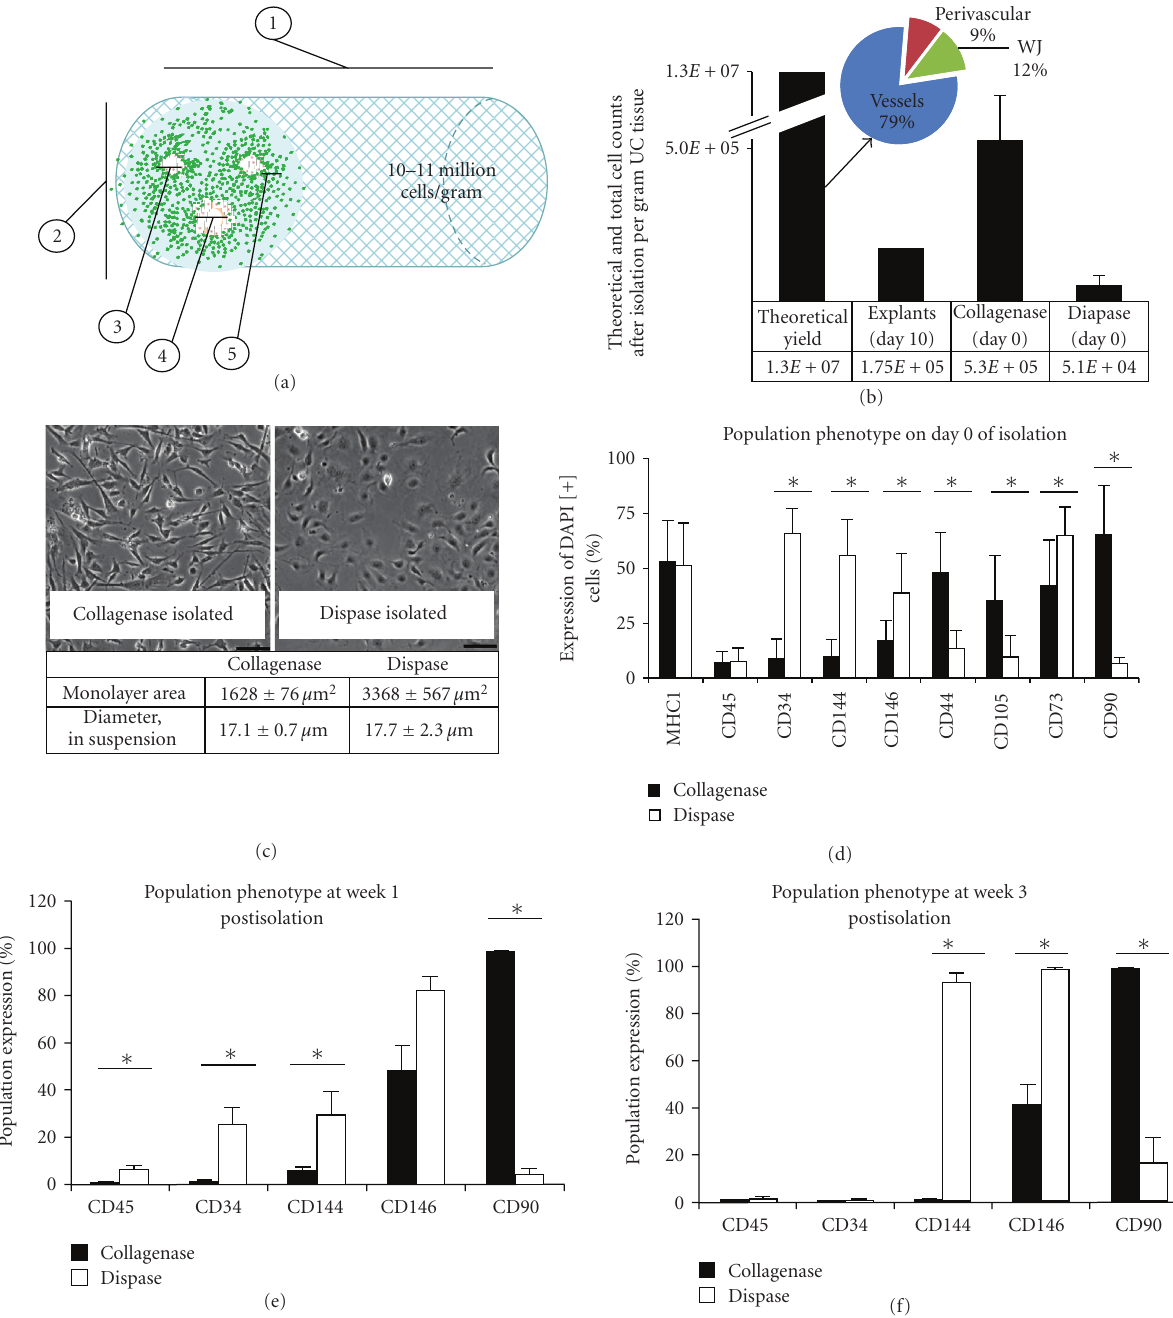
Figure 2: Tissue processing and method of isolation a ff ect total cell yield and population phenotype. (a) Physical properties of the UC tissue provide an estimate that 10-11 million cells per gram can be isolated from the tissue (also see Table 1 and Table 1 in Supplementary Material available online at doi:10.1155/2009/789526). (b) The theoretical yield of 10-11 million cells/UC gram includes 79% vascular cells, 9% perivascular cells, and 12% WJ cells. Distinct phenotypes based on enzymatic method are evident by both morphology (c) and molecular phenotype (d)–(f). (c) Cell area or spreading in 2D monolayer is significantly larger for dispase-isolated cells versus collagenase-isolated cells (mean ± s.e.m., P < . 001), although the cells have similar diameter or size when measured prior to surface adhesion. (d) Mean surface marker expression on day 0 of isolation. Collagenase-isolated cell populations have a significantly higher level of expression of CD44 ( P = .005), CD105 ( P = .014), and CD90 ( P < .001), as compared to dispase-isolated cells that exhibit a significantly higher level of endothelial marker expression, CD34 ( P < .001), CD144 ( P < .001), and CD146 ( P = .049), and CD73 ( P < .001) which was also detected in the endothelium. (e) Marker expression at week 1 postisolation. Significant di ff erences were detected for expression of CD45 ( P = .01), CD34 ( P < .001), CD144 ( P = .006), and CD90 ( P = .003). (f) Marker expression at week 3 postisolation. Significant di ff erences were detected for expression of CD144 ( P = .017), CD146 ( P = .008), and CD90 ( P = .001). The use of collagenase enzyme yields a cell population with significantly higher MSC marker expression levels in comparison to both dispase enzyme digestion and mechanical dissociation.The latter two methods, however, yield populations with significantly higher endothelial cell marker expression levels than the collagenase enzyme